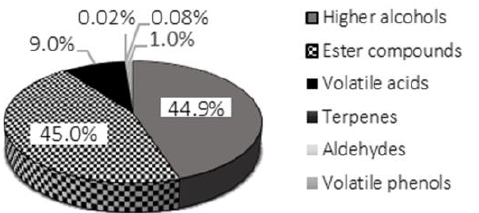
Figure 3. Pie chart reporting the percentage composition of higher alcohols, esters, volatile acids, terpenes, aldehydes and volatile phenols detected in the headspace of W1 wine sample, based on average chromatographic peaks areas.